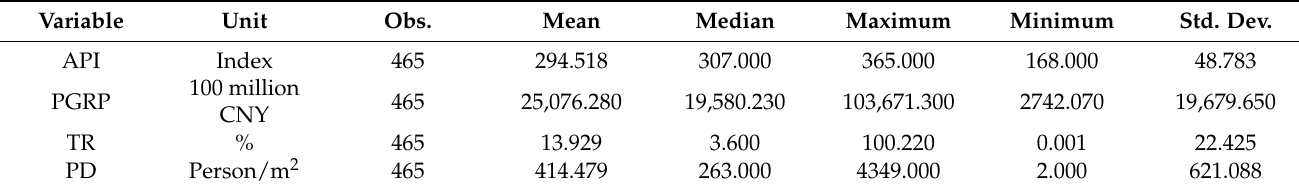
Table 1. Descriptive Statistics of